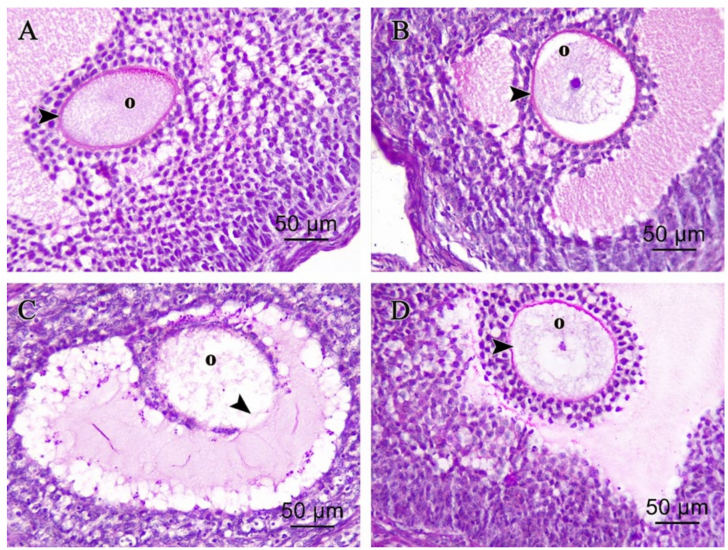
Figure 5. Photomicrographs of (PAS × 400) stained ovarian sections. ( A ) Control group, and ( B ) mela- tonin group showing: Graafian follicle displayed positive PAS reactions of intact continuous zona pellucida (arrowhead) surrounding intact oocyte (O). ( C ) Cisplatin-treated group showed degenerating Graafian follicle with faint PAS reactions in damaged interrupted zona pellucida (black arrowhead) and oocyte (O). ( D ) Cisplatin + melatonin-treated group showing: Graafian follicle displayed positive PAS reactions of intact continuous zona pellucida (arrowhead) surrounding intact oocyte